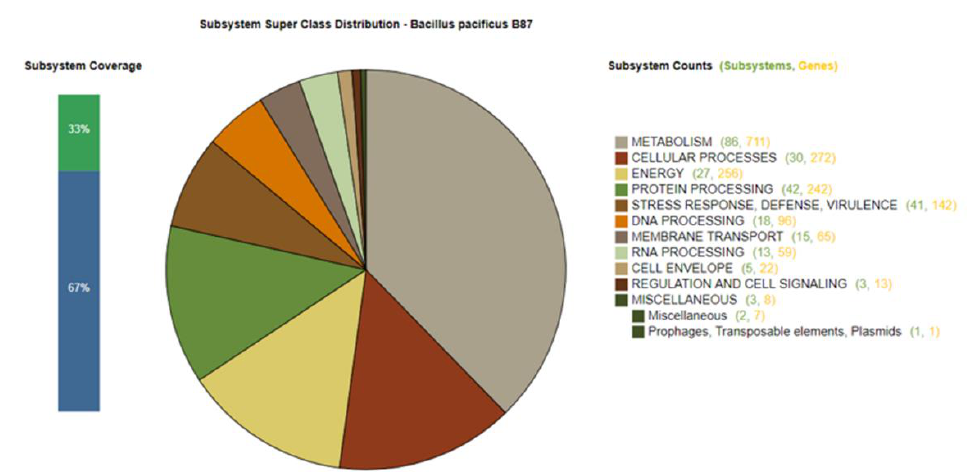
Figure 3. Overview of the subsystem categories of the annotated draft whole genome of Bacillus sp. B87 from the RAST server. The pie chart shows the number of genes related to individual subsystems. The bar graph on the left reveals the subsystem coverage. The ratio of coding sequences annotated in the SEED subsystem (33%) and outside of the SEED subsystem (67%) is indicated. A phylogenetic tree based on core genes was reconstructed in PATRIC using the whole-genome sequence of Bacillus sp. B87 (Figure 4A). This phylogenomic analysis revealed that Bacillus sp. B87 was closely related to strains of Bacillus pacificus . The 16S rRNA